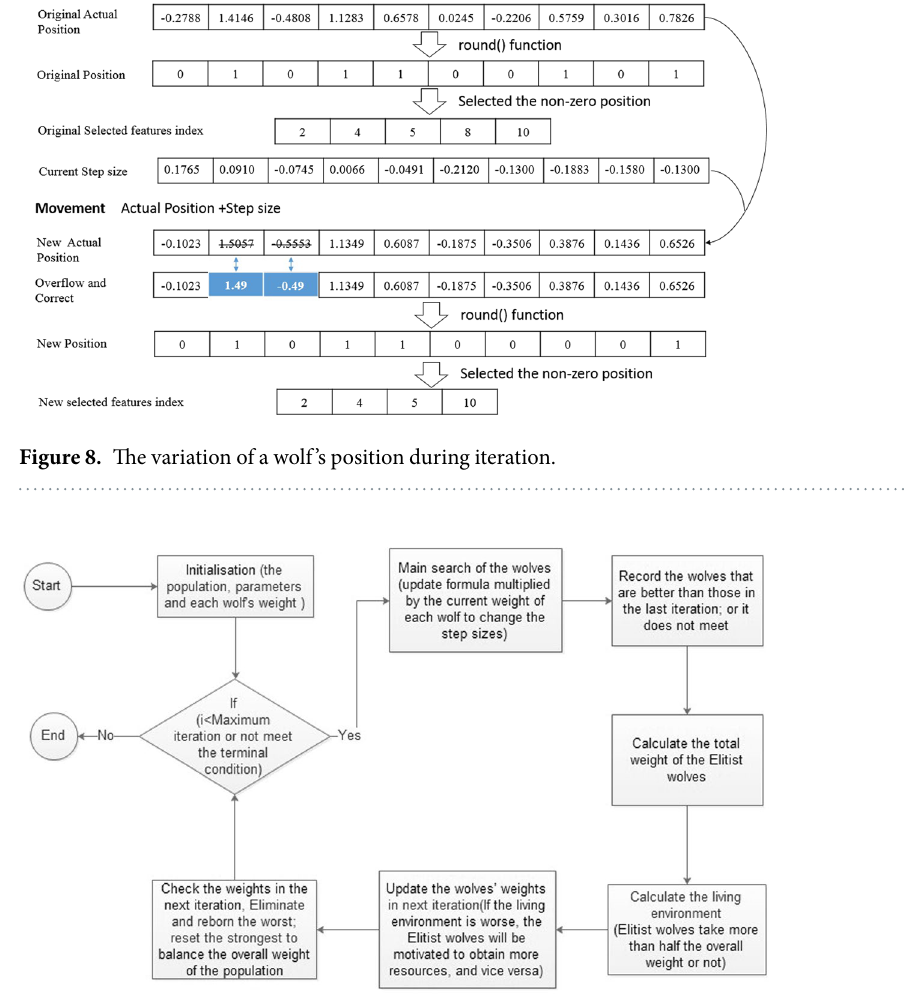
Figure 9. Flow chart of the elitist process of